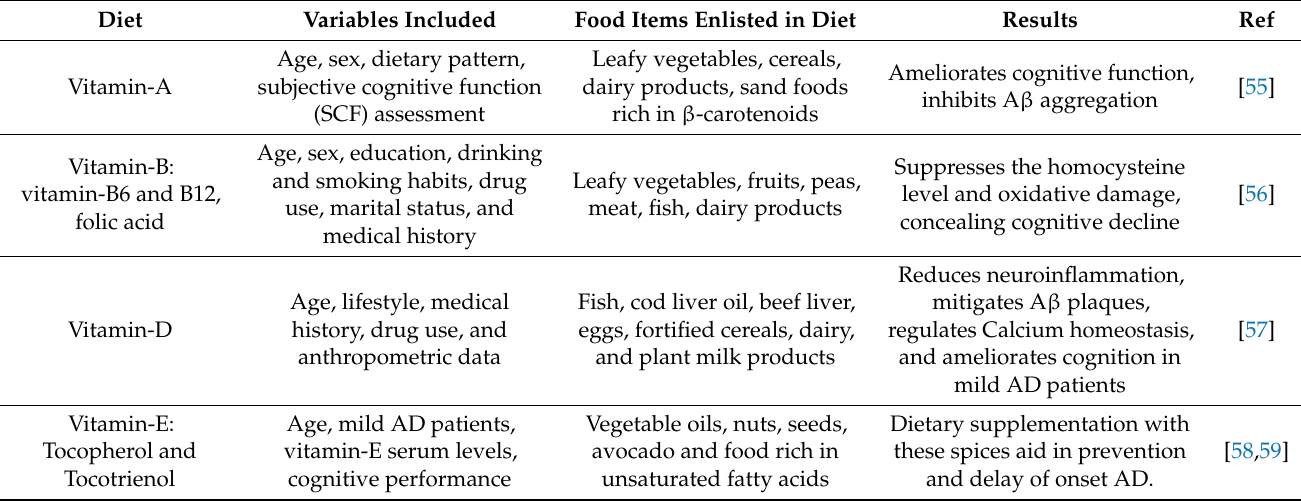
Table 2. Vitamins and AD associated